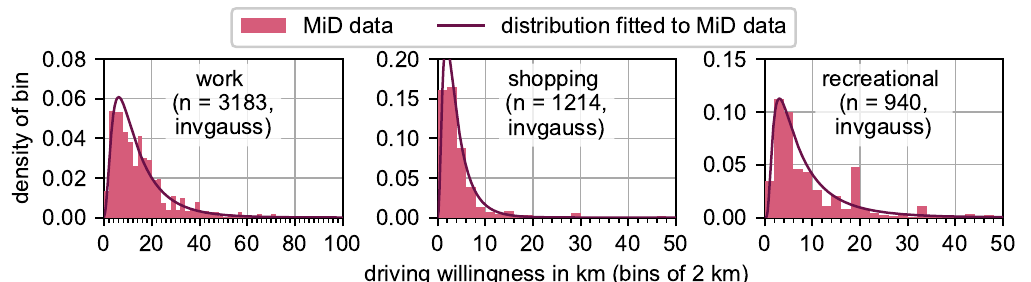
Figure 5. Schematic illustration of the process of generating driving willingness distributions. The exemplary results are depicted in Figure 6.